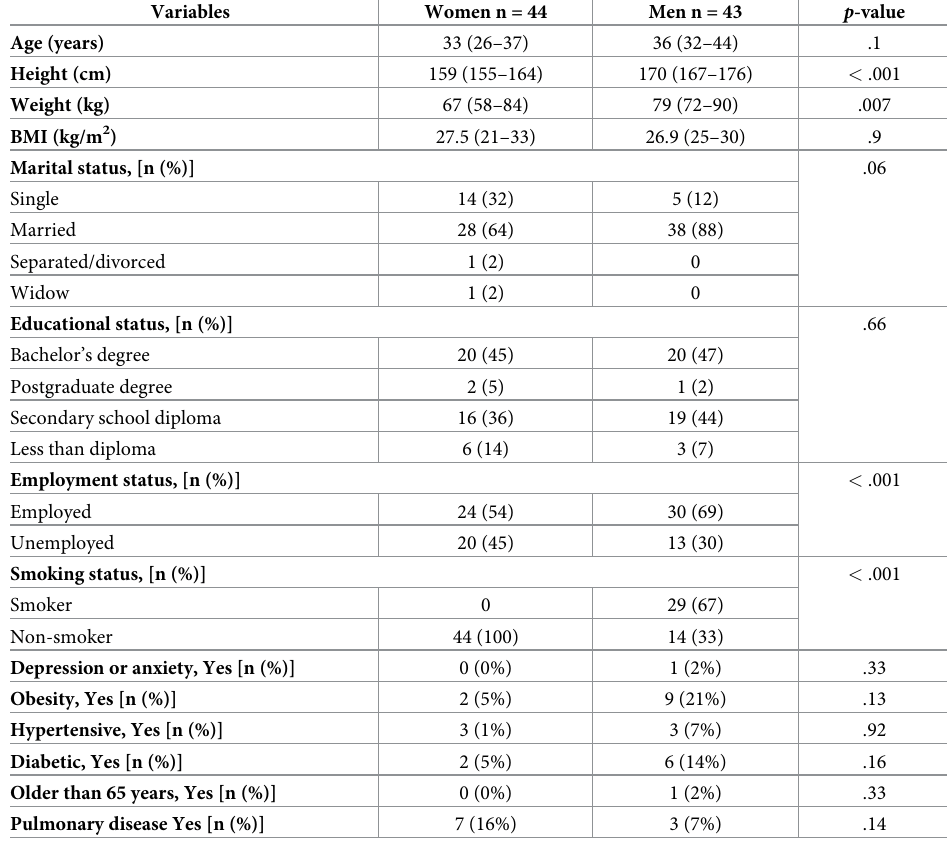
Table 1. Demographic and general health characteristics of the